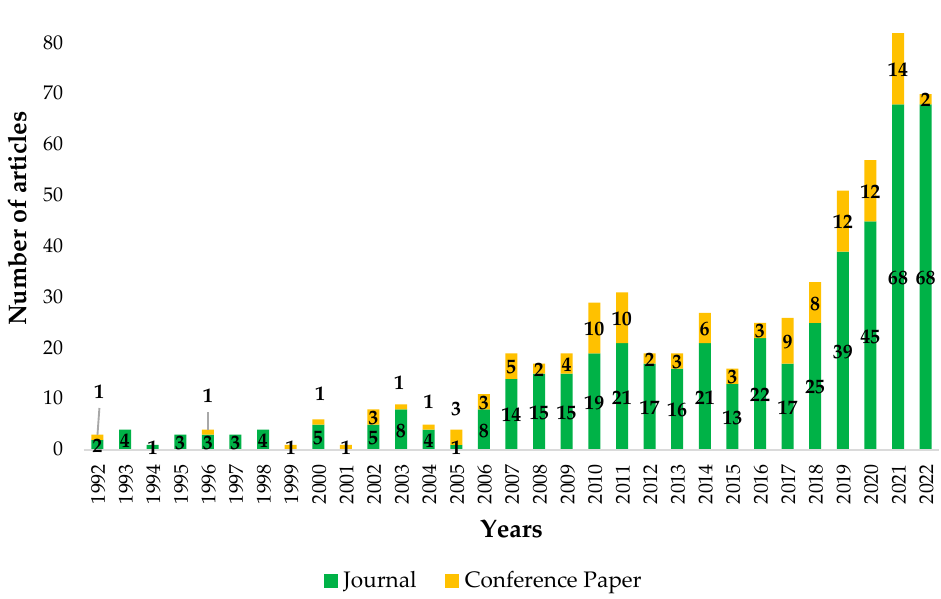
Figure 1. Distribution of articles by year. Source: own study based on: [35].